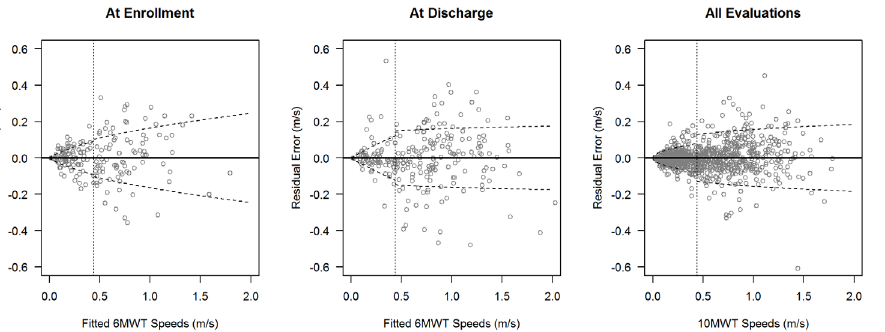
Figure 3. Residuals from linear models predicting 6MWT speeds with 10MWT speeds at enrollment, discharge, and all evaluations. Linear models fit to slow and fast walkers (separated by dotted line). Dashed lines are estimated residual standard errors from models.